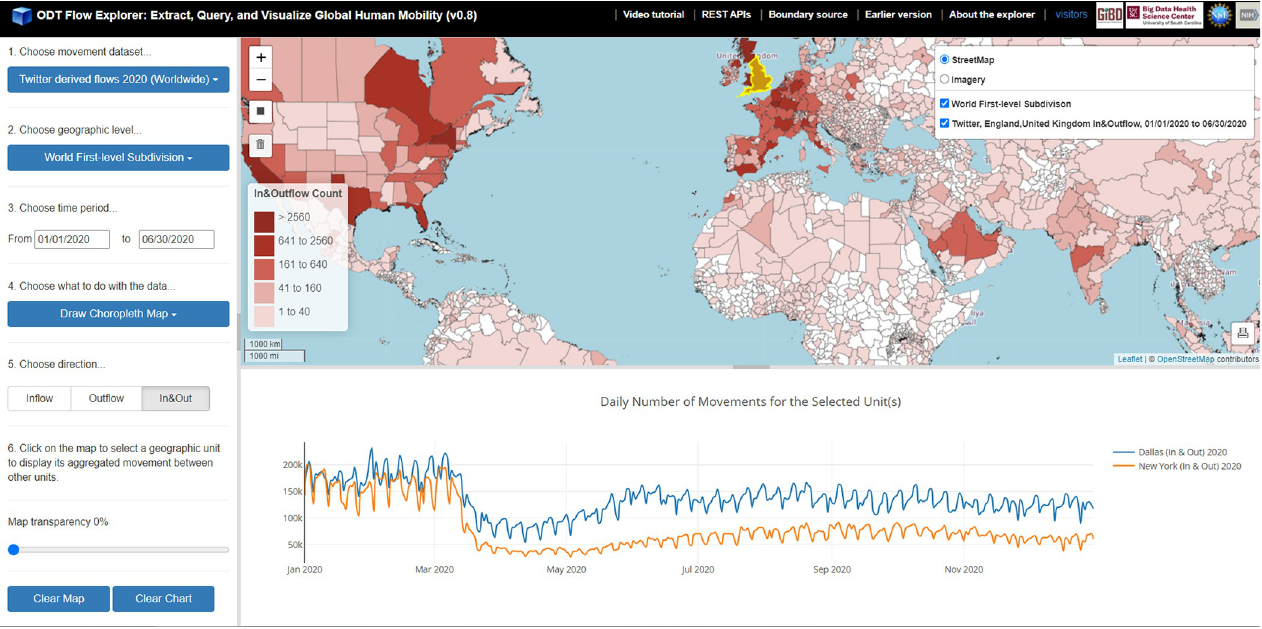
Fig 4. The user interface of the interactive spatial web portal. The world country and world first-level subdivision boundary data are derived from https://gadm.org.